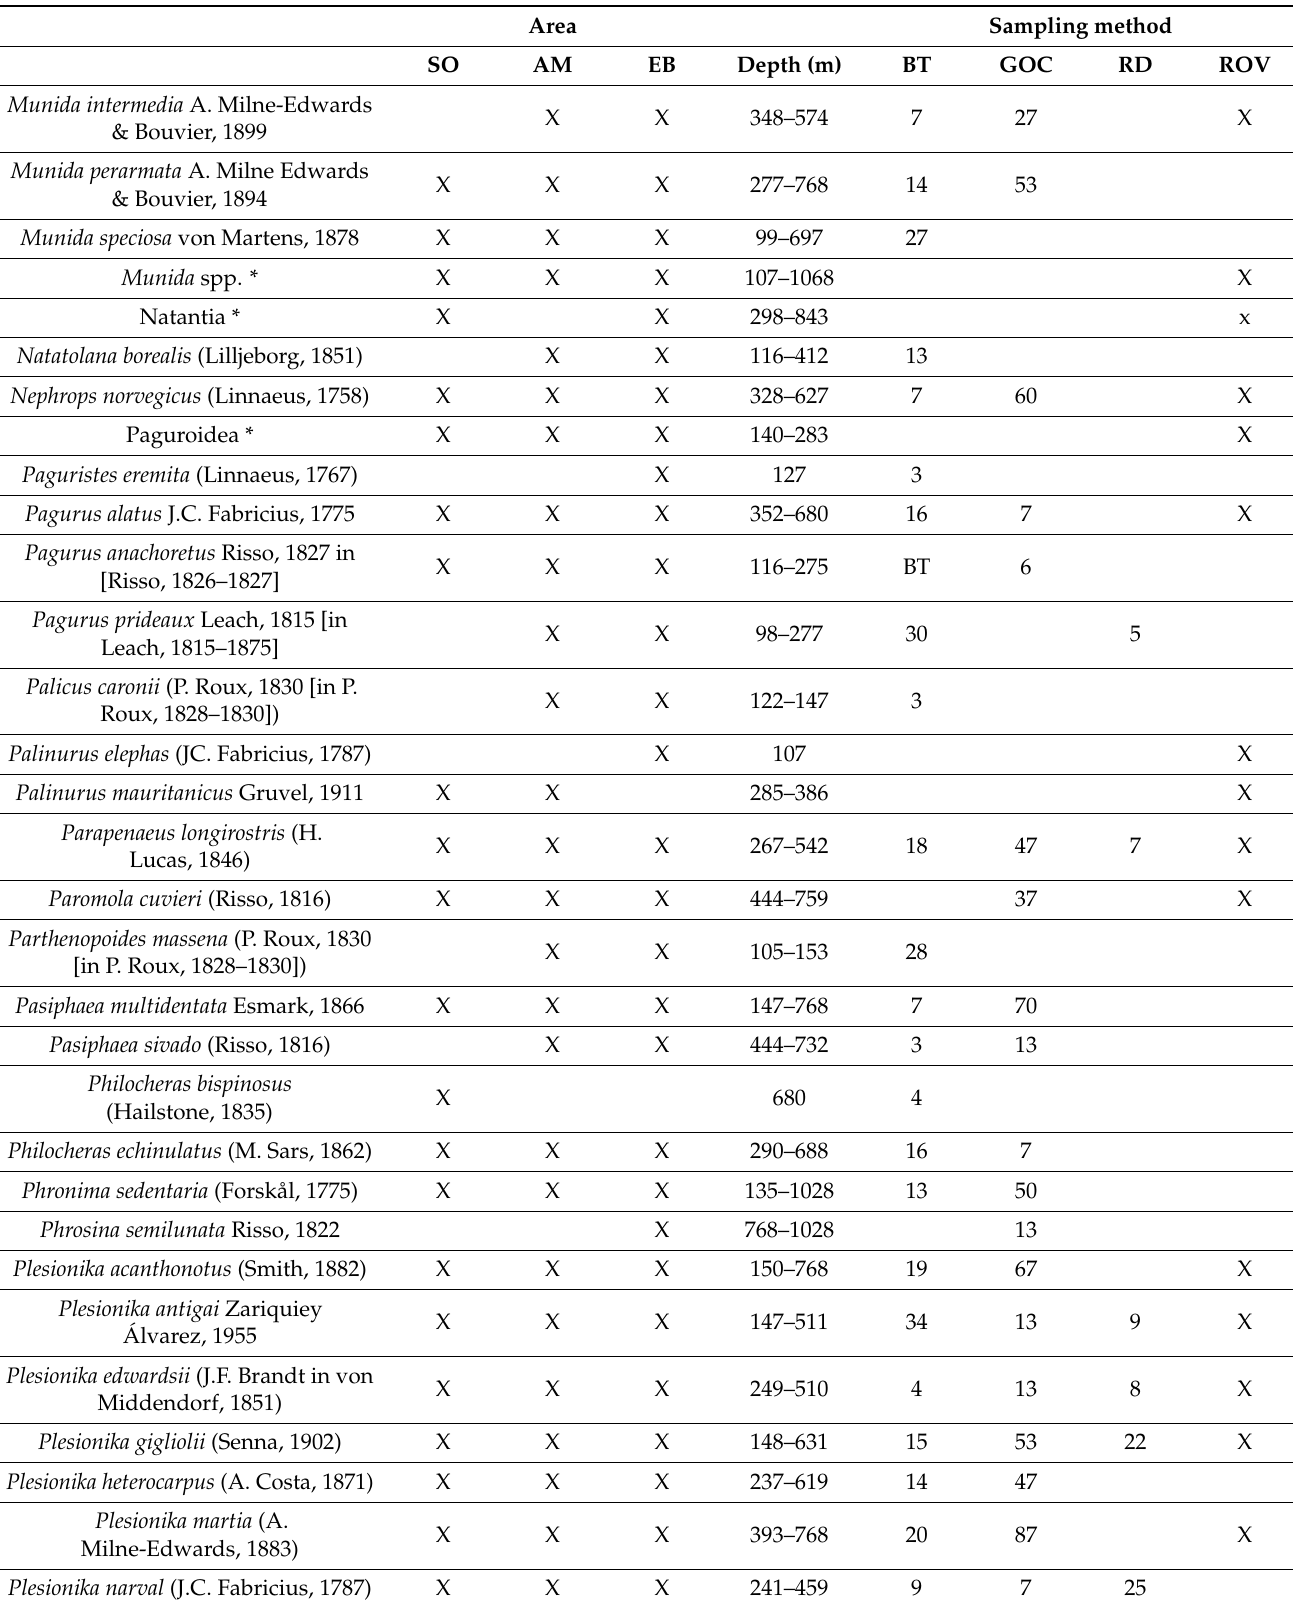
Table A7. Cont. Area Sampling